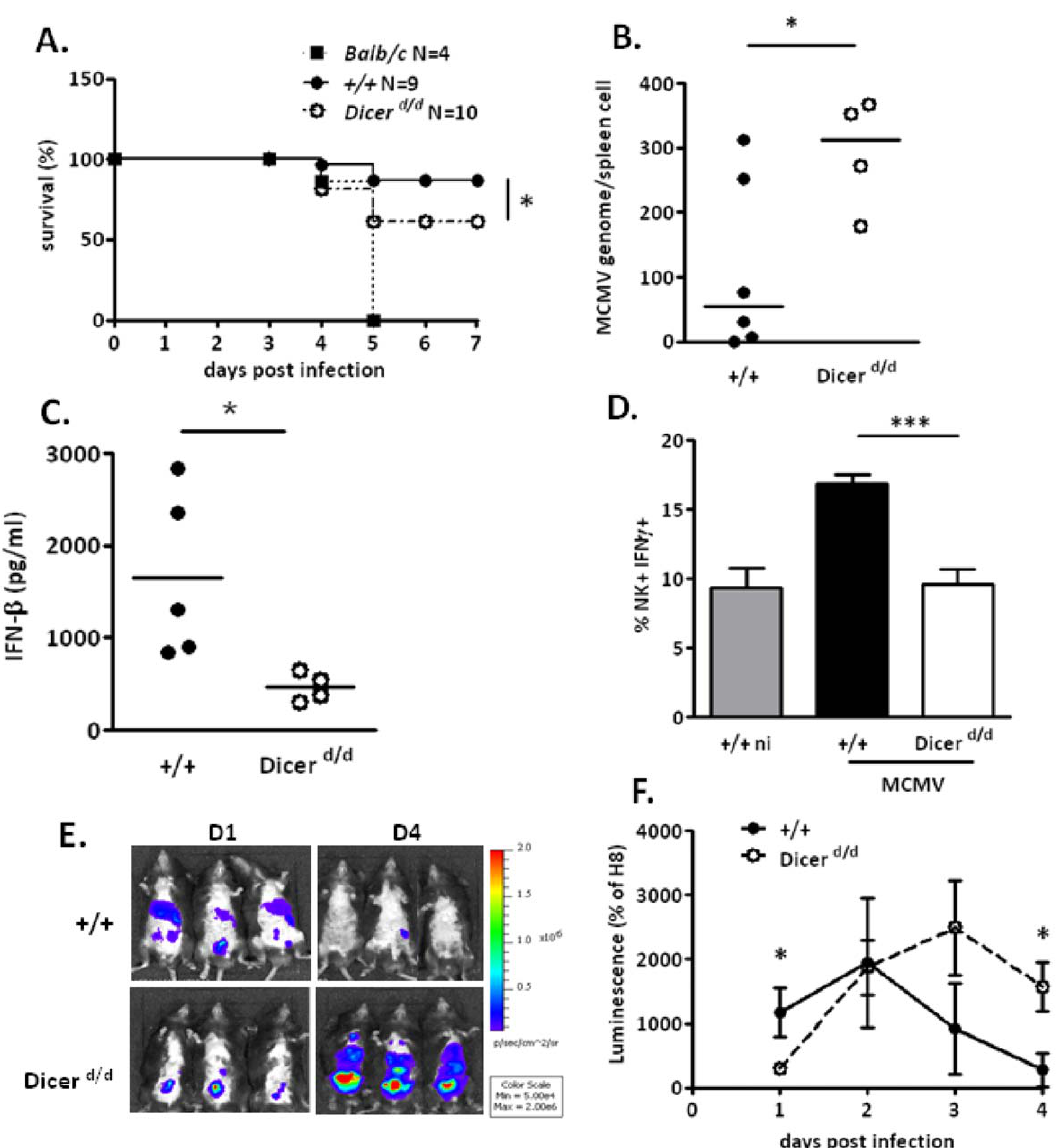
Figure 4. Dicer d/d mice are hypersusceptible to acute MCMV infection. A. Survival curve of control mice ( + / + , black spots), Dicer d/d (white spots) and BALB/c animals (black squares) upon acute MCMV infection (5 6 10 5 pfu/mouse). B. Absolute quantification of the MCMV genome by qPCR in infected wild-type mice ( + / + ) and Dicer d/d mutants. C. IFN- b quantification by ELISA in the serum of controls ( + / + ) and mutants 36 hours post- infection (h.p.i). D. Quantification of activated NK cells (NKp46 + /IFN- c + ) in the spleen of non-infected (NI) and infected controls ( + / + ) and Dicer d/d mice 72 h.p.i. 6 animals/group were used. E. Snapshot images showing MCMV-derived luminescence 1 (D1) and 4 days (D4) upon MCMV-Luc infection of controls ( + / + ) and Dicer d/d mice. F. Time-course analysis of the luminescence quantification in MCMV-Luc infected controls (n=6 + / + ; black spots) and mutants (n=5; dotted line and white spots).